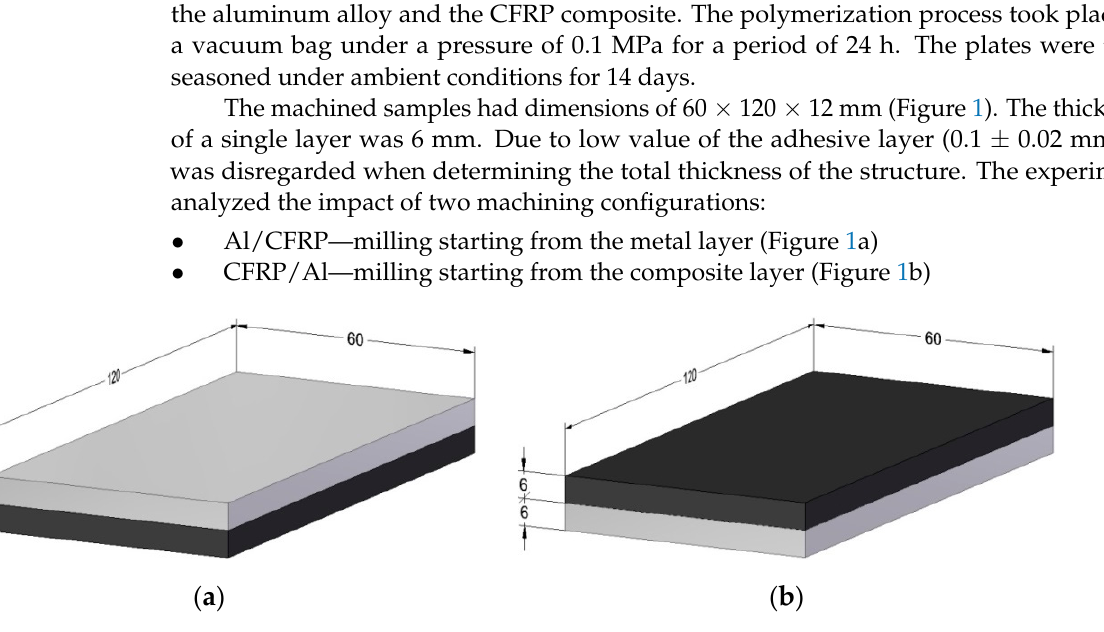
Figure 1. Tested sample: ( a ) Al/CFRP configuration, ( b ) CFRP/Al configuration (Unit: mm). Simultaneous circumferential milling using a VMC 800 HS machining centre (AVIA, Warsaw, Poland) was employed during the tests. The spindle performed right-hand rotation. The shorter edge of the sample (60 mm) was machined during the tests. Each sample was machined three times and the arithmetic mean of the three measurements was used in the analysis. Figure 2 presents the scheme of the milling